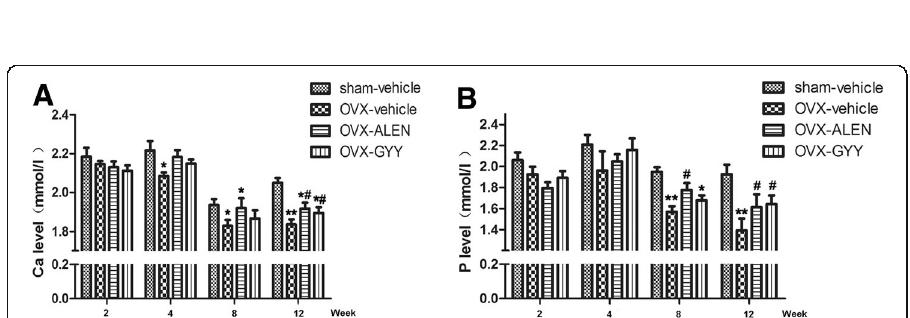
Fig. 3 The effect of GYY4137 on the amount of calcium and phosphorus in the plasma of ovariectomized rats. a The amount of calcium in the plasma. b The amount of phosphorus in the plasma. * p <0.05 vs. sham-vehicle group; ** p <0.01 vs. sham-vehicle group; # p <0.05 vs. OVX-vehicle group; ## p <0.01 vs. OVX-vehicle. OVX-vehicle: ovarectomized rats treated with vehicle; OVX-ALEN: ovarectomized rats treated with alendronate sodium; OVX- GYY: ovarectomized rats treated with